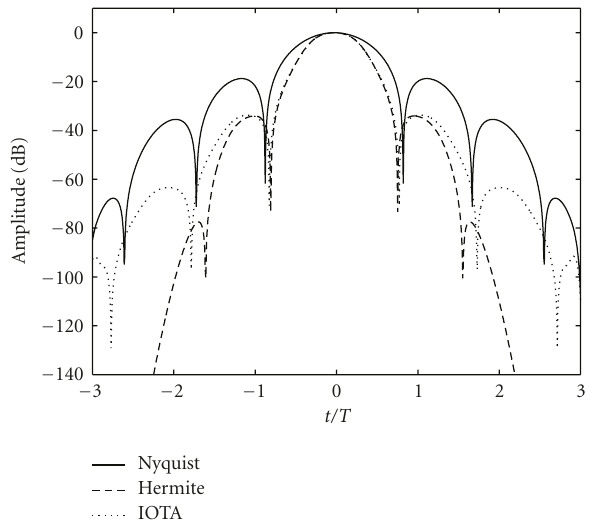
Figure 13: Magnitude of frequency response of three designs of prototype filter of length 6 T